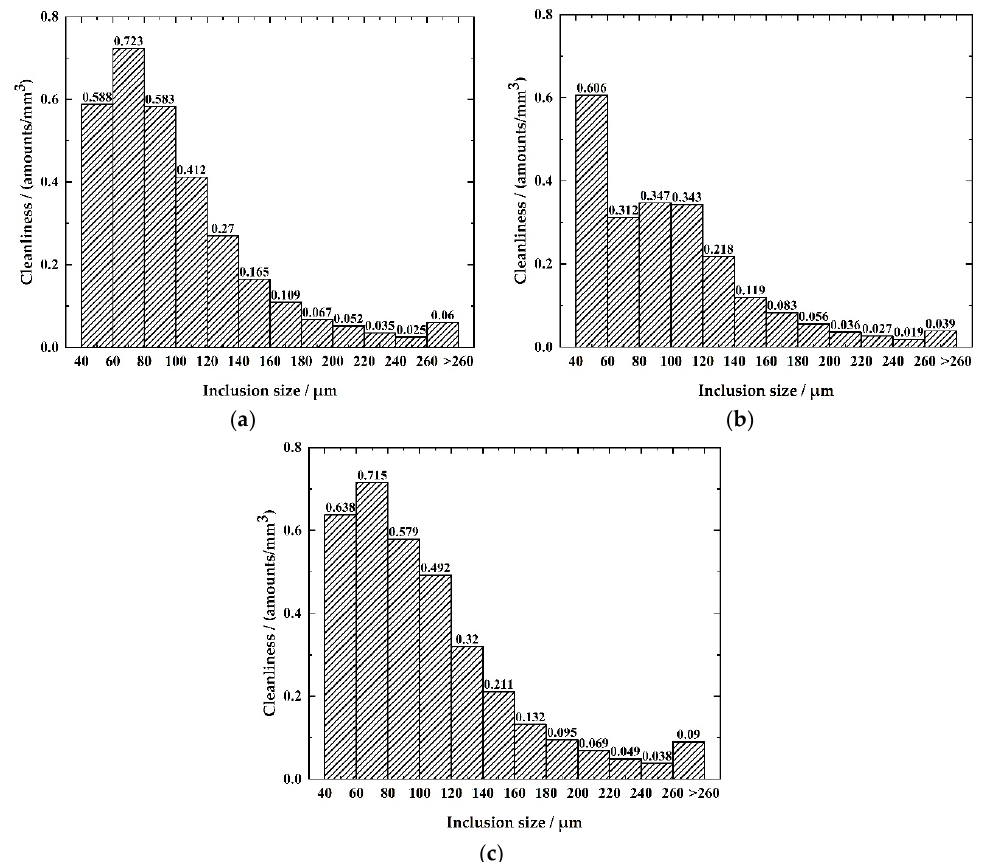
Figure 10. Histogram of size distribution of inclusions obtained from each strand ( a ) statistics of inclusion size of S1 specimen; ( b ) statistics of inclusion size of S2 specimen; and ( c ) statistics of inclusion size of S3 specimen.